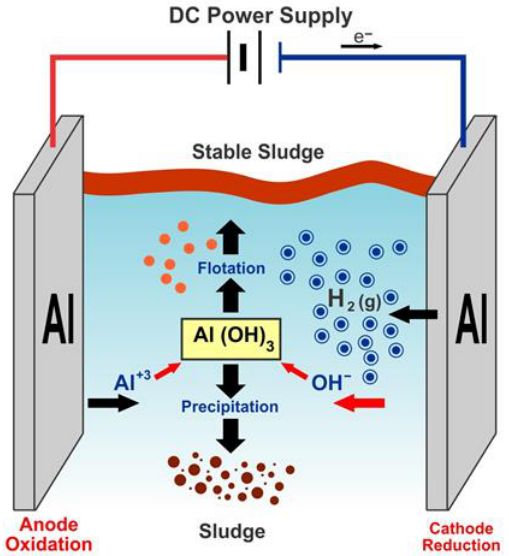
Figure 4. Simplified diagram of the electrocoagulation process with an aluminum